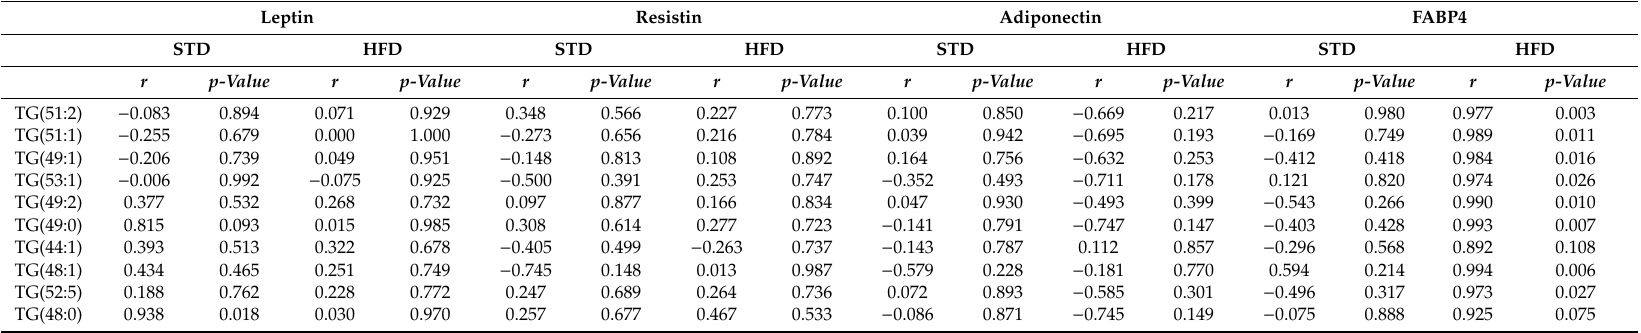
Table 2. Correlations of plasma adipokines and liver triglycerides identified by both LC–MS and LDI–MS tissue imaging in both STD- and HFD-fed mice. Data are adjusted for weight, plasma NEFAs, and plasma